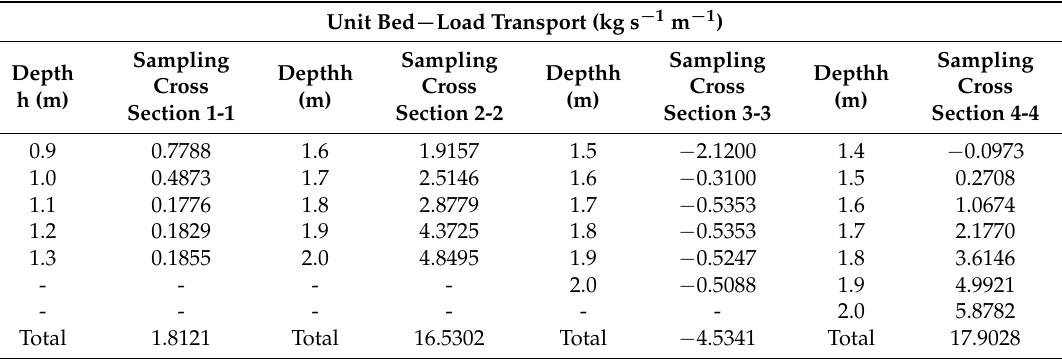
Table 7. Budget of the unit bed-load transport—the Lososina